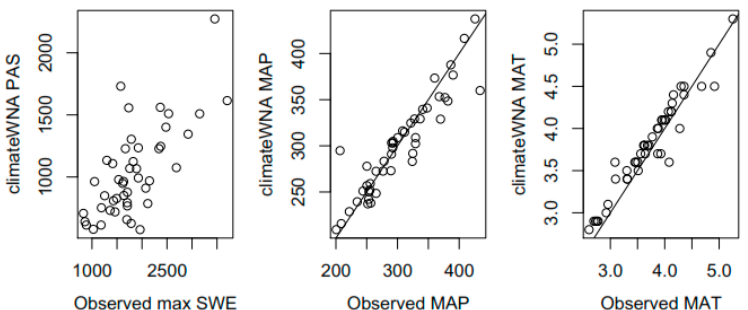
Figure A1. A comparison of climate variable observations taken at the Paradise meteorological station (located on the south side of Mt. Rainier) corrected to the permanent forest demography plot on the south side using PRISM normals (see Ettinger et al., 2011), vs. climateWNA for the same permanent forest demography plot for the years 1965–2007. PAS = precipitation as snow; SWE = snow-water equivalent; MAP = mean annual precipitation; MAT = mean annual temperature.